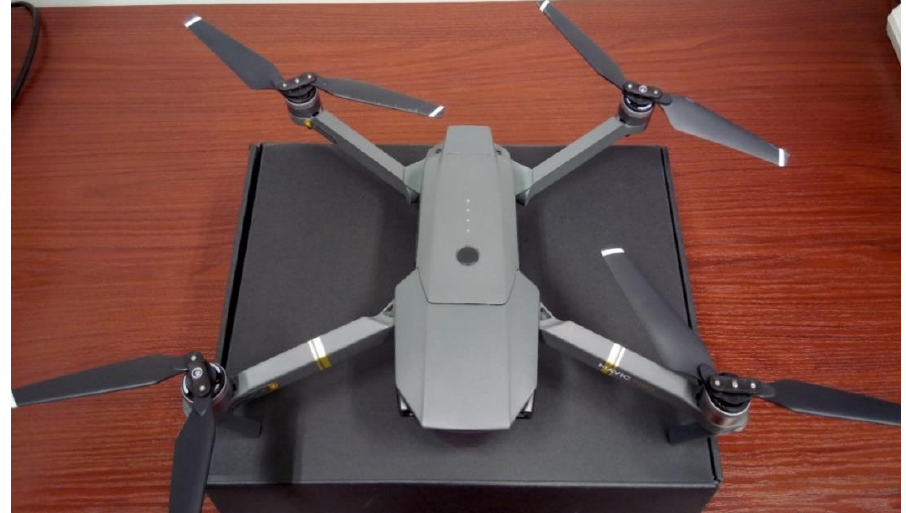
Figure 1. The unmanned aerial vehicle (UAV) used in the experiment. The UAV is DJI Mavic Pro. The maximum speed of the UAV is 40 mph (65 kph) in sport mode without wind. The maximum hovering time is 24 min (no wind). The overall flight time is 21 min (normal flight, 15% remaining battery level). The maximum takeoff altitude is 16,404 feet (5000 m). The GPS/GLONASS satellite positioning systems is used. During the experiment, the drone hovered at a height of 1.8 m in the laboratory.